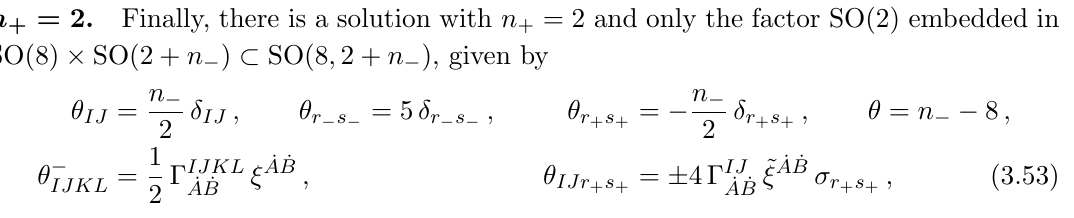
Table 9. Mass spectrum for the SU(4 group SO( n ) U(4 ; 1). (cid:2) (cid:0) n = +